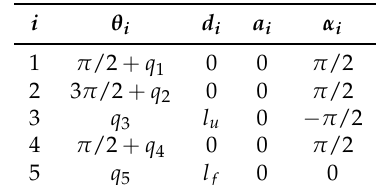
Table 1. DH parameters of the kinematic arm chain.